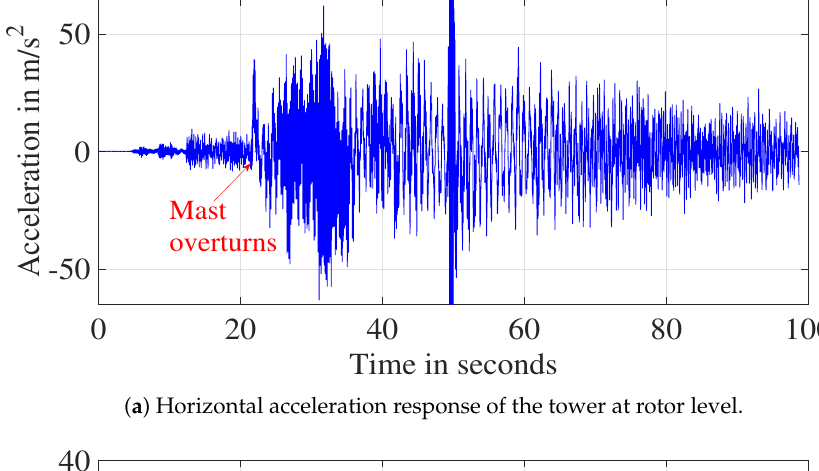
( a ) Horizontal acceleration response of the tower at rotor level.